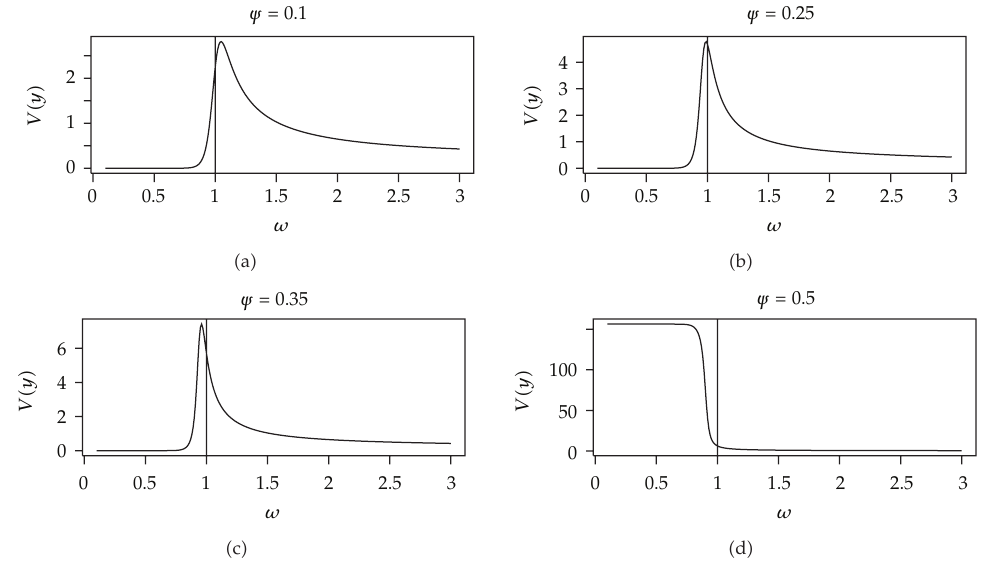
Figure 4: Variance of Y n for various values of ω at each value of ψ and n (cid:5)